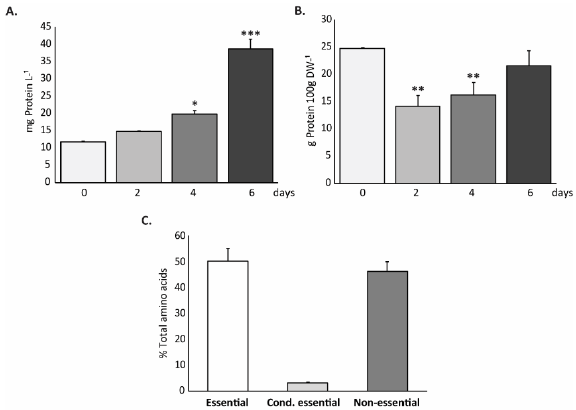
Figure 4. Protein production and amino acid composition of H. coffeaeformis . ( A ) Protein production (mg of proteins∙L −1 ). ( B ) Proteins considering total biomass (g Protein 100 g∙DW −1 ) ( C ) Essential, conditionally essential and non-essential amino acids. The graphics show average values ± standard deviation (n = 3). * statistically significant (p < 0.05), *** very highly significant differences (p < 0.001) between conditions. Table 2. Amino acid profile of H. coffeaeformis . Amino acid composition (% of total amino acids) of H. coffeaeformis after 6 days of culture in the photobioreactor. The table shows average values ± standard deviation (n = 3). The amino acid classification shown was taken from [17], taking into account the nutritional needs of aquatic animals.